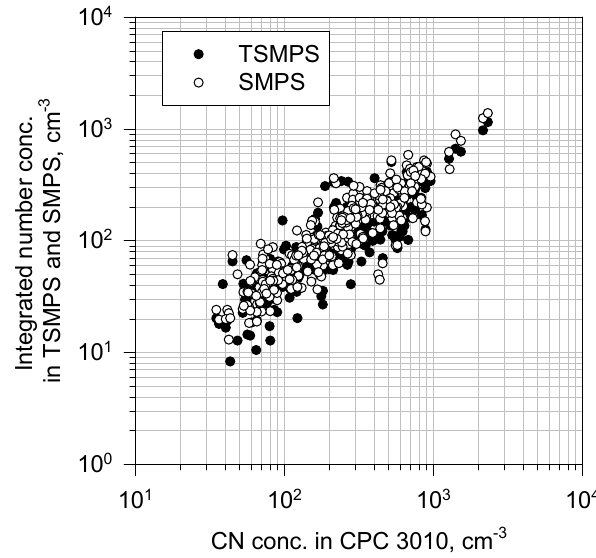
Fig. 2. Relationship among CN concentration in CPC-3010, the integrated number concentrations ( D p : 10–167nm) of TSMPS and SMPS during the room temperature